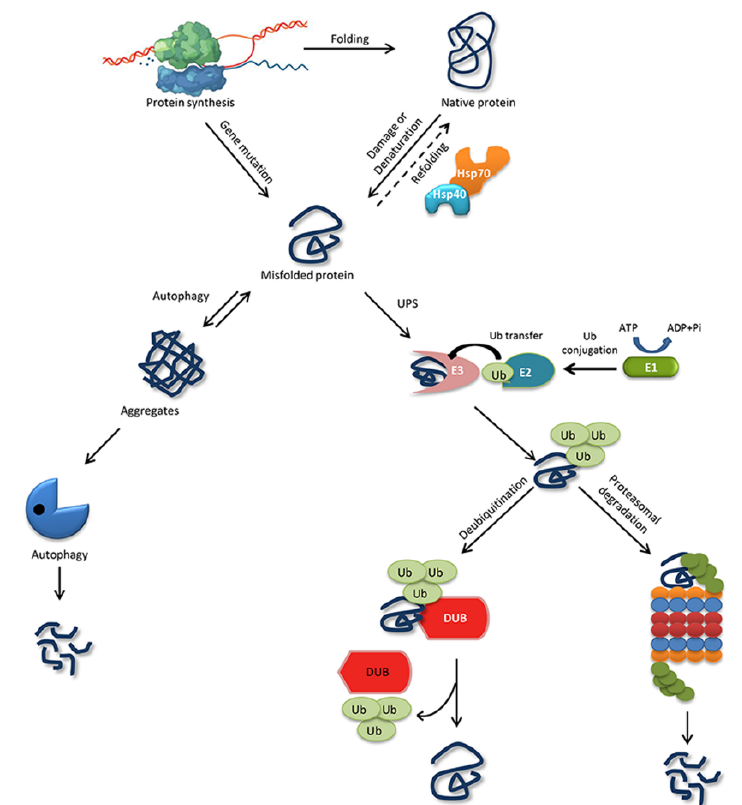
Figure 1. Protein folding, misfolding, and degradation. Protein folding starts during the ribosomal translation process and attain the native conformation to execute cellular processes. The native folded proteins are often misfolded due to mutations and other environmental factors. Molecular chaperones catalyze the folding/refolding events, disaggregation of the protein aggregates, and targeting the protein for degradation. Aggregates are typically degraded by autophagy, whereas the ubiquitin proteasome system (UPS) degrades the destabilized/misfolded proteins by covalent attachment of a ubiquitin molecule assisted by E1-E2-E3 enzymes. The ubiquitinated proteins are recognized by the 26S proteasome and are degraded. However, the ubiquitin moiety is cleaved off by Deubiquitinating enzymes (DUBs) and the protein can be rescued from the degradation cycle.